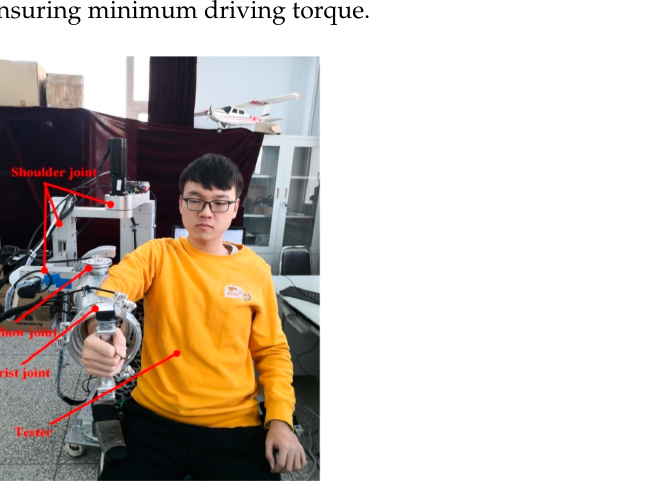
Figure 10. Wearable upper limb rehabilitation robot with characteristics of the tension mecha- nism [105].